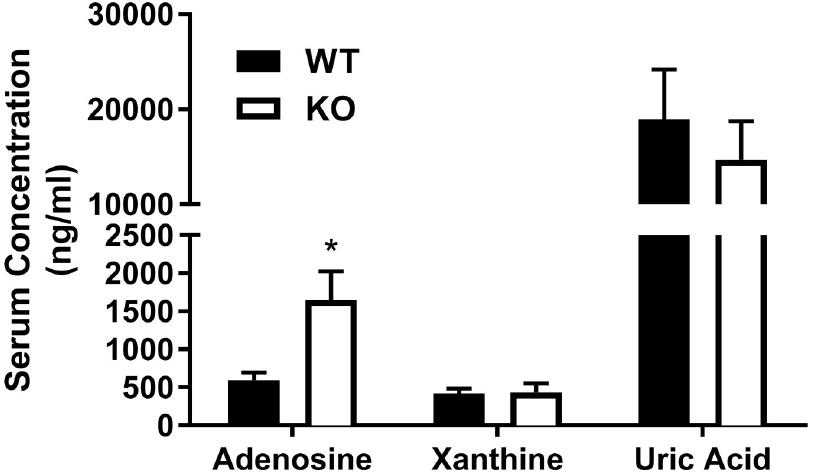
Fig 1. Plasma adenosine levels. Blood was obtained from wild-type (WT) and Slc29a1 -null (KO) mice via cardiac puncture (in the presence of dilazep, EHNA and iodotubercidin to limit adenosine metabolism) and processed for HPLC analysis of adenosine, xanthine and uric acid content. � Significant difference between wild-type and Slc29a1 - null mice for the indicated parameter (Student’s t-test for unpaired samples, two-tailed, P < 0.05, N = 5).